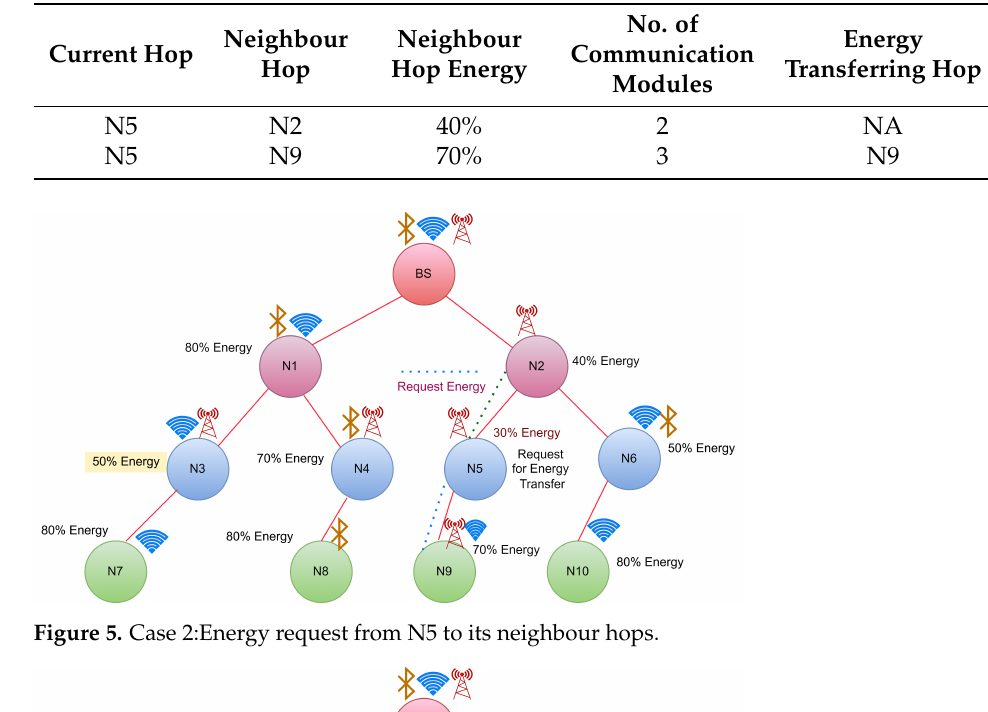
Figure 4. Case 1:Energy transfer from BS to N1. Table 6. Neighbours energy availability at node N5.